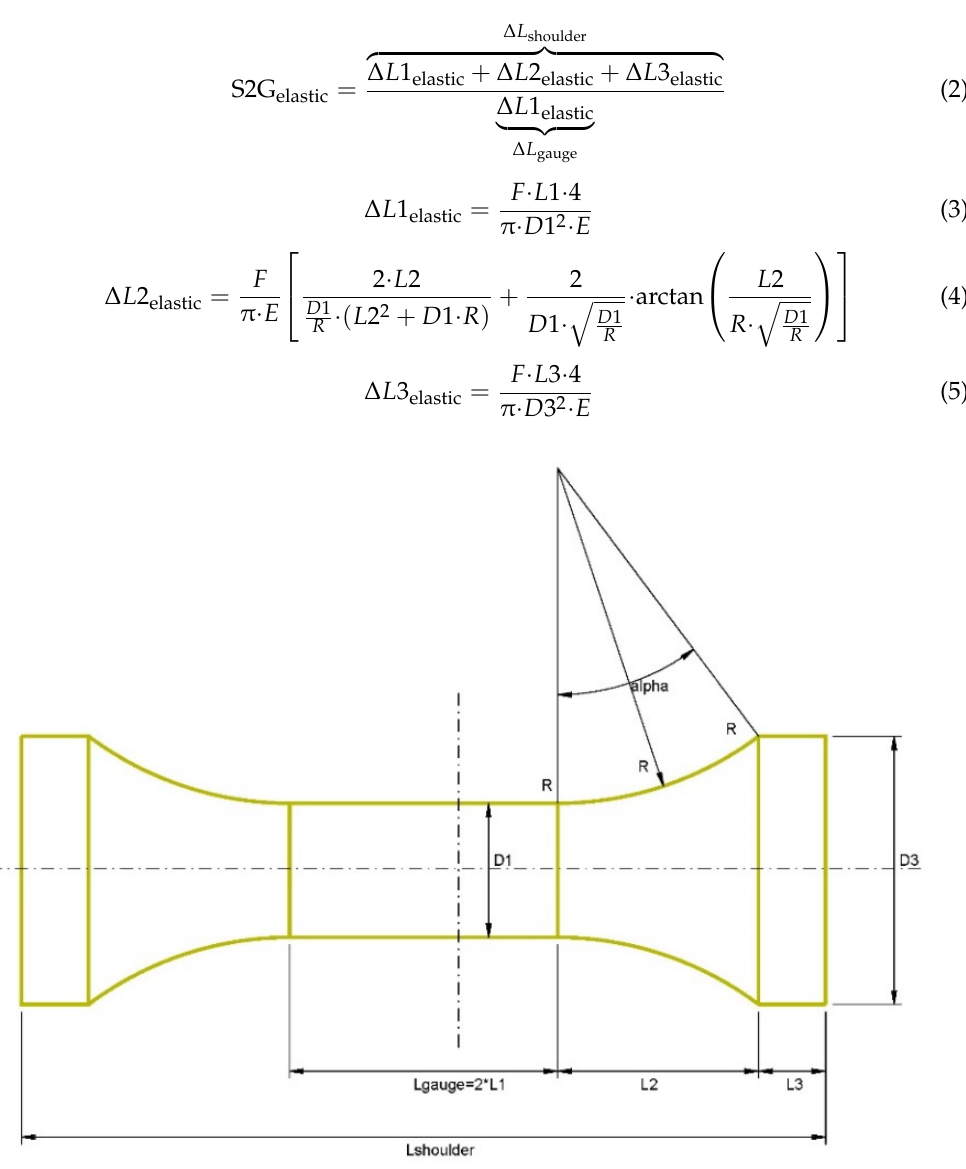
Figure 1. Sketch of a fatigue